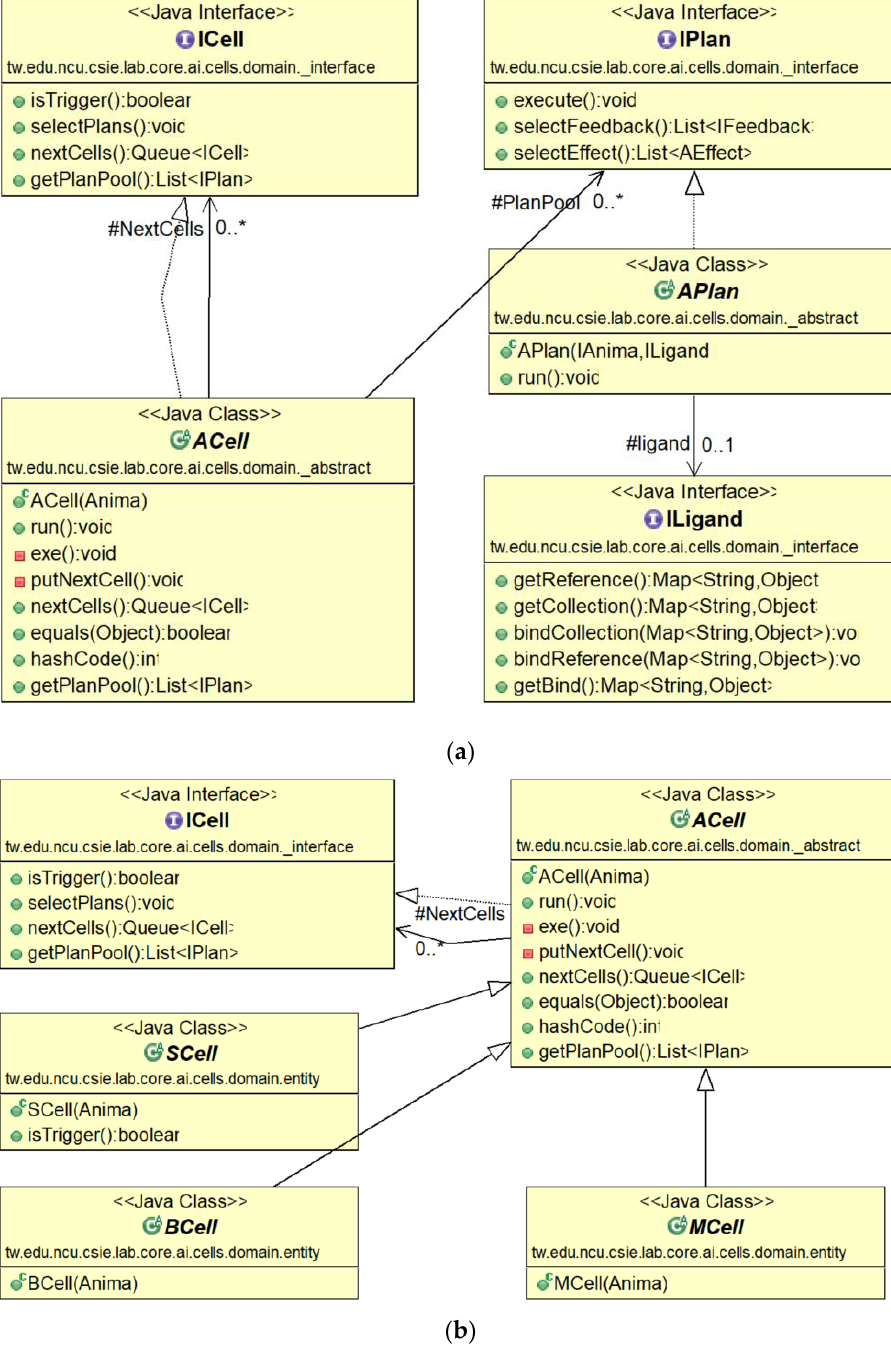
Figure 4. The class diagram from the single-cell perspective: ( a ) each cell will use the ligand to transmit the information in the environment to the plan, and the plan performs the work delivered by the cell; ( b ) There are three implementations of cell: SCell (sensory cell), BCell (brain cell), and MCell (motor cell). MCell (motor